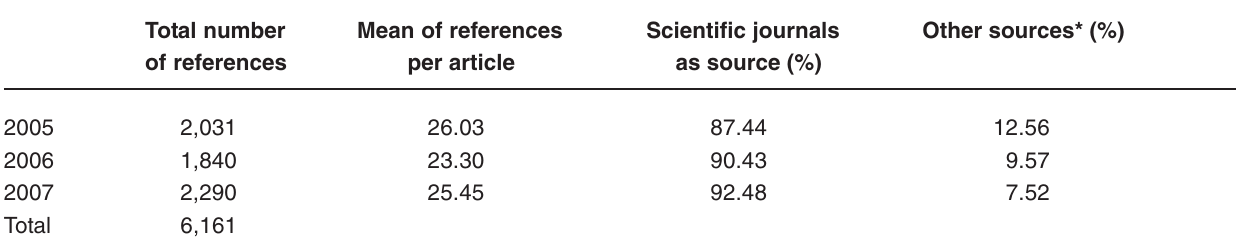
TABLE 4- Characteristics of the references cited in articles published in the JAOS between 2005 and